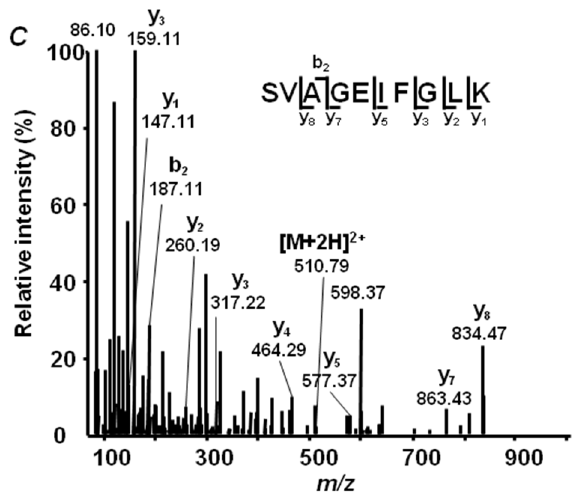
Figure 3. Tandem mass spectra of ( A ) m / z 733.3 corresponding to the peptide NM Ox AVTQFEPADAR, which represents residues 131–143 of aminopeptidase (protein accession Lj1g3v1787580.1, Lotus japonicus ), ( B ) m / z 700.89 corresponding to the peptide GLVLTFITDFFK, which represents residues 179–190 of the eukaryotic translation initiation factor (protein accession G7KRJ1, Medicago truncatula ), and ( C ) m / z 510.79 corresponding to the peptide SVAGEIFGLK, which represents residues 170–180 of the protein from glutamine synthetase family (protein accessionV7BHN3, Phaseolus vulgaris ).